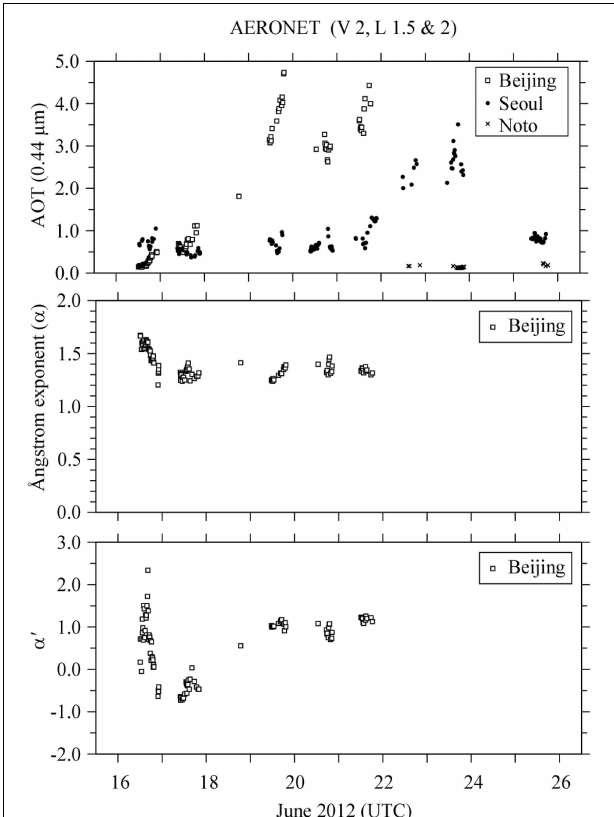
FIGURE 5 | AERONET data in June 2012. The top, middle, and bottom figures represent AOT (0.44 µ m), Ångström exponent ( α ) and the derivative of Ångström exponent ( α ′ ), where λ 1 , λ 2 , and λ 3 , are 0.87, 0.675, and 0.44 µ m,